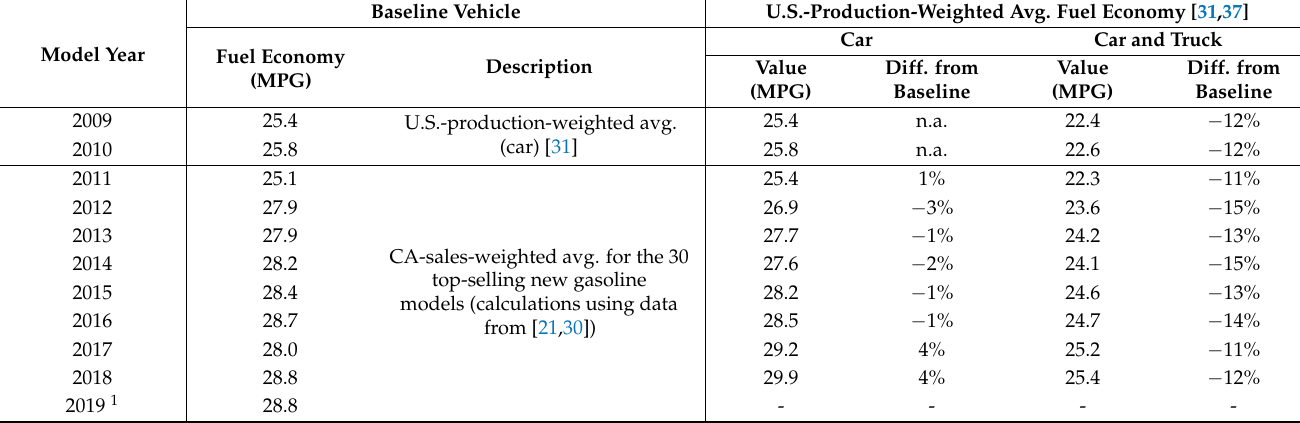
Table A1. Baseline-Vehicle Fuel Economy Compared with U.S.-Production-Weighted Avg. Fuel Economy.